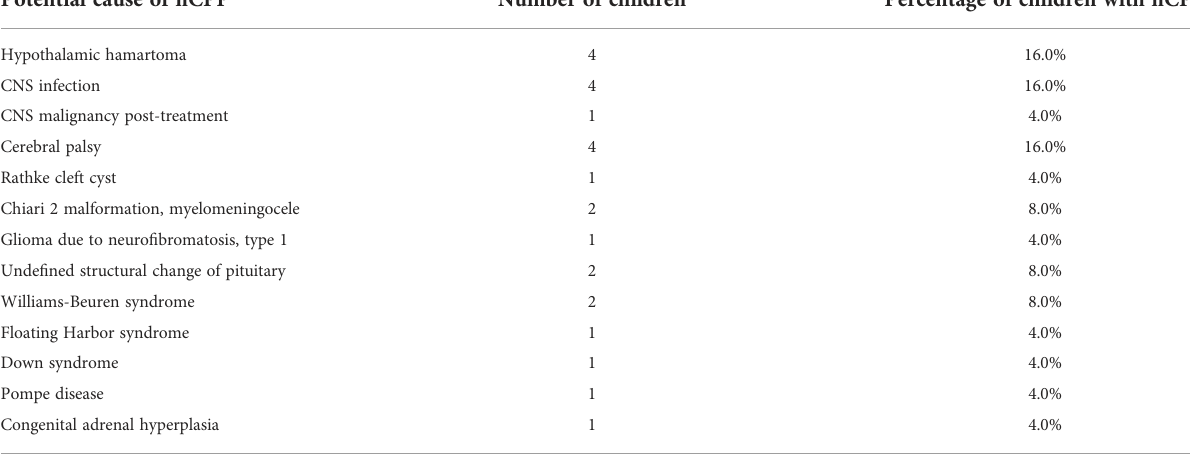
TABLE 1 Potential causes of central precocious puberty in the group considered non-idiopathic. Potential cause of